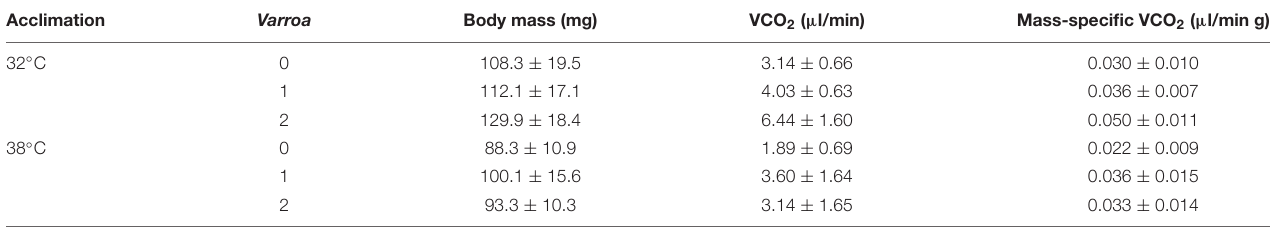
TABLE 2 | Body mass and metabolic rate in honeybees from two thermal acclimation treatments subjected to different levels of parasitism ( n = 10 for each group). Acclimation